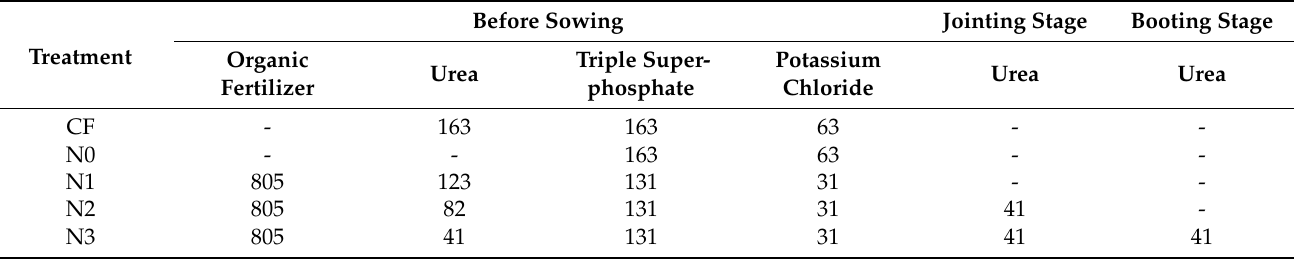
Table 1. The schedule of fertilization during wheat growing season (kg ha − 1 ). Note: CF, conventional fertilization; N0, no nitrogen fertilizer; N1, 25% of chemical nitrogen fertilizer was replaced by organic fertilizer, and all fertilizer was applied before sowing; N2, 25% of chemical nitrogen fertilizer was replaced by organic fertilizer, 2/3 of chemical nitrogen fertilizer was applied before sowing